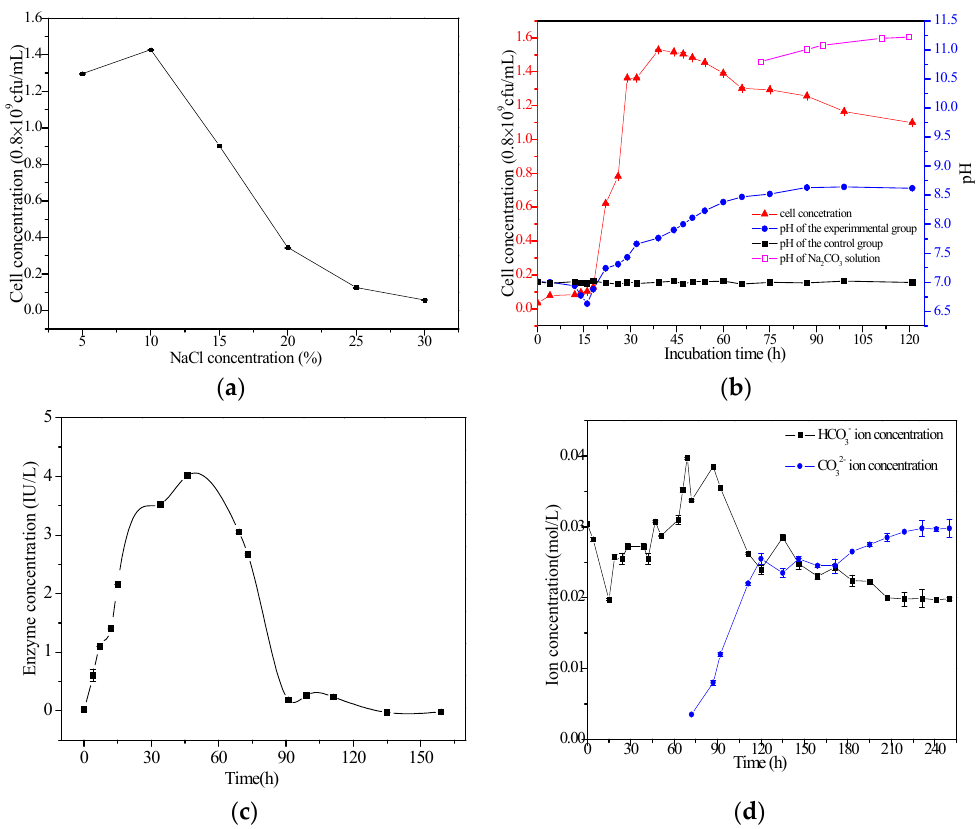
Figure 3. Physiological and biochemical characteristics of S. epidermidis Y2 bacteria. ( a ) Growth curve of S. epidermidis Y2 bacteria at different sodium chloride concentrations after being cultivated for 24 h; ( b ) Growth curve and pH curve; ( c ) carbonic anhydrase (CA) activity; ( d ) Carbonate and bicarbonate ion concentrations in the culture medium.